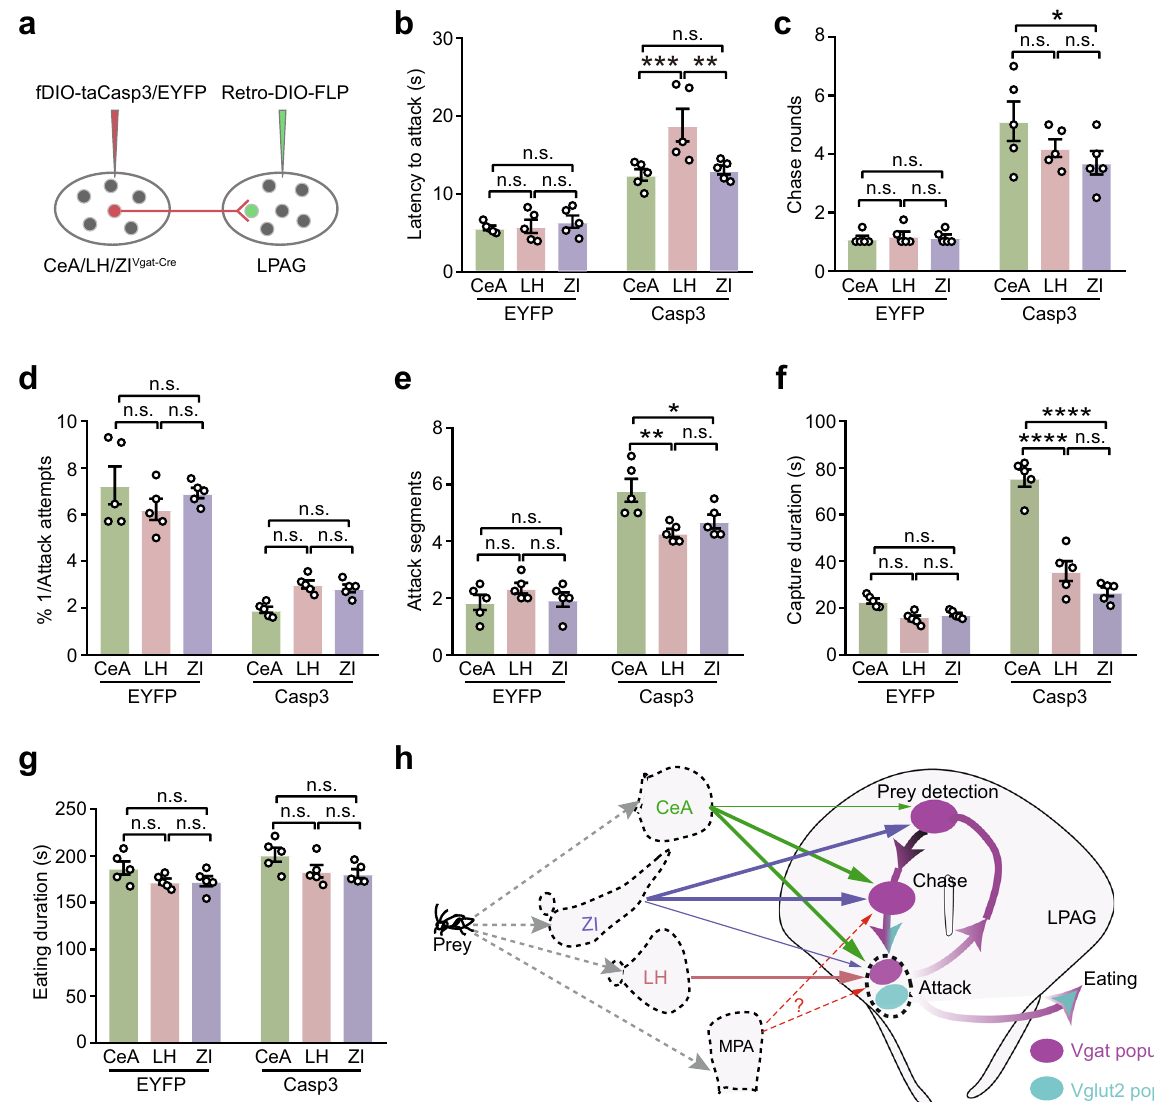
Fig. 6 Lesions of LPAG afferents impair predatory hunting. a Experimental scheme of ablation of LPAG-projecting GABAergic neurons from the CeA/LH/ZI. b Comparison of the effect on the latency to attack after ablation of LPAG-projecting GABAergic neurons from the CeA/LH/ZI ( n = 30 mice, two-way ANOVA, Tukey ’ s multiple comparisons test, P = 0.991, P = 0.854, P = 0.9123, P = 0.0007, P = 0.9041, P = 0.0021). c Comparison of the effect on the chase rounds after ablation of LPAG-projecting GABAergic neurons from the CeA/LH/ZI ( n = 30 mice, two-way ANOVA, Tukey ’ s multiple comparisons test, P >0.9999, P >0.9999, P >0.9999, P = 0.2405, P = 0.0284, P = 0.9919). d Comparison of the effect on the attack ef fi ciency after ablation of LPAG-projecting GABAergic neurons from the CeA/LH/ZI ( n = 30 mice, two-way ANOVA, Tukey ’ s multiple comparisons test, P = 0.1904, P = 0.833, P = 0.4512, P = 0.1576, P = 0.2587, P = 0.9533). e Comparison of the effect on the attack segments after ablation of LPAG-projecting GABAergic neurons from the CeA/LH/ZI ( n = 30 mice, two- way ANOVA, Tukey ’ s multiple comparisons test, P = 0.3874, P = 0.9612, P = 0.54, P = 0.0014, P = 0.0185, P = 0.54). f Comparison of the effect on the capture duration after ablation of LPAG-projecting GABAergic neurons from the CeA/LH/ZI ( n = 30 mice, two-way ANOVA, Tukey ’ s multiple comparisons test, P = 0.117, P = 0.2629, P = 0.8872, P <0.0001, P <0.0001, P = 0.052). g Comparison of the effect on the eating duration after ablation of LPAG-projecting GABAergic neurons from the CeA/LH/ZI ( n = 30 mice, two-way ANOVA, Tukey ’ s multiple comparisons test, P = 0.2131, P = 0.227, P = 0.992, P = 0.1128, P = 0.0602, P = 0.9465). h Summary of functions of LPAG across predatory hunting. A neuronal ensemble sequence is formed in the LPAG across the whole predatory process. Vgat + population (light purple) in the LPAG encodes the introduction, chase, and attack, while Vglut2 + population (light blue) encodes the attack. The neuronal activity of LPAG clusters across predatory processes depends on GABAergic inputs from the CeA (green line), LH (orange line), and ZI (purple line). GABAergic inputs from the CeA mainly control prey chase and attack, GABAergic inputs from the LH control prey attack, and GABAergic inputs from the ZI mainly control introduction and chase phases. The role of the inputs from the MPA on hunting needs further investigation. Data are presented as the mean±SEM. Source data are provided as a Source Data